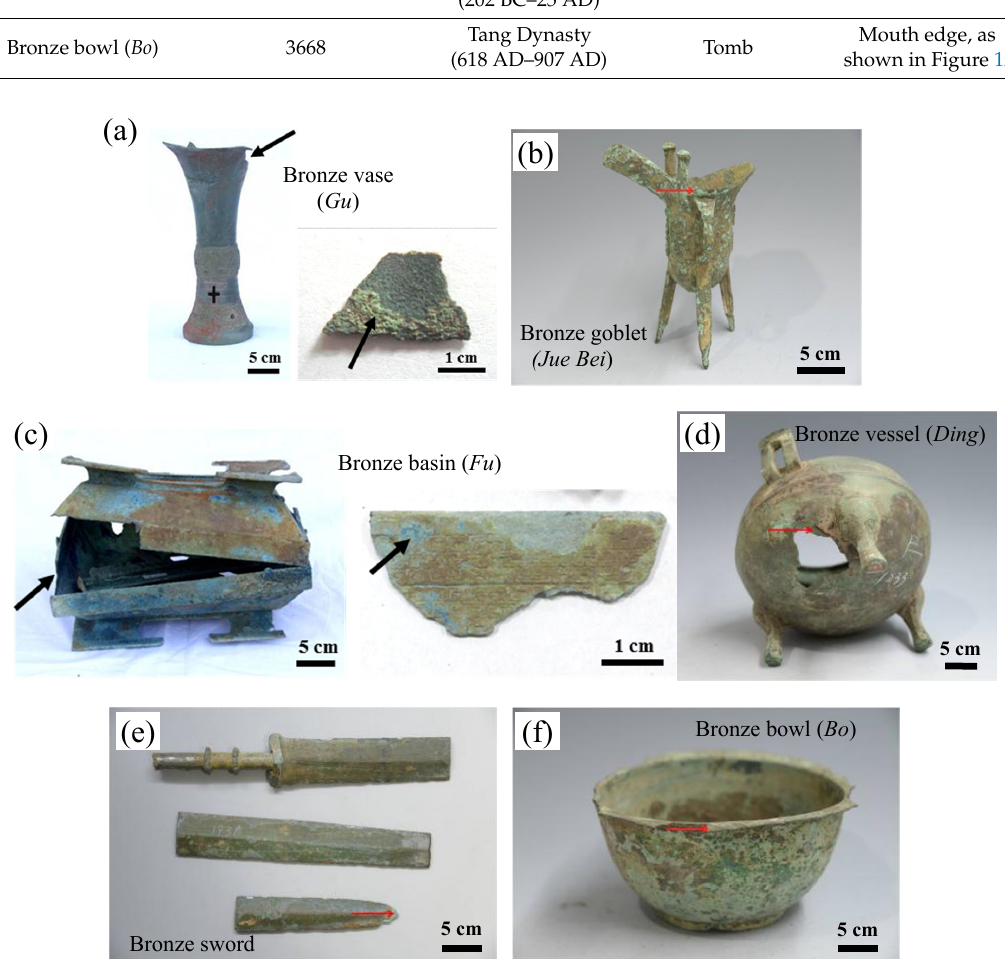
Figure 1. Images of the ancient bronzes—the arrows indicate the sampling position: ( a ) Bronze vase ( Gu ) (Shang Dynasty, collection No.: ABG-2209-1); ( b ) Bronze goblet ( Jue Bei ) (Shang Dynasty, collection No.: 3253); ( c ) Bronze basin ( Fu ) (Spring and Autumn Period, collection No.: ABF-5155); ( d ) Bronze vessel ( Ding ) (Western Han Dynasty, collection No.: 1233); ( e ) Bronze sword (Western Han